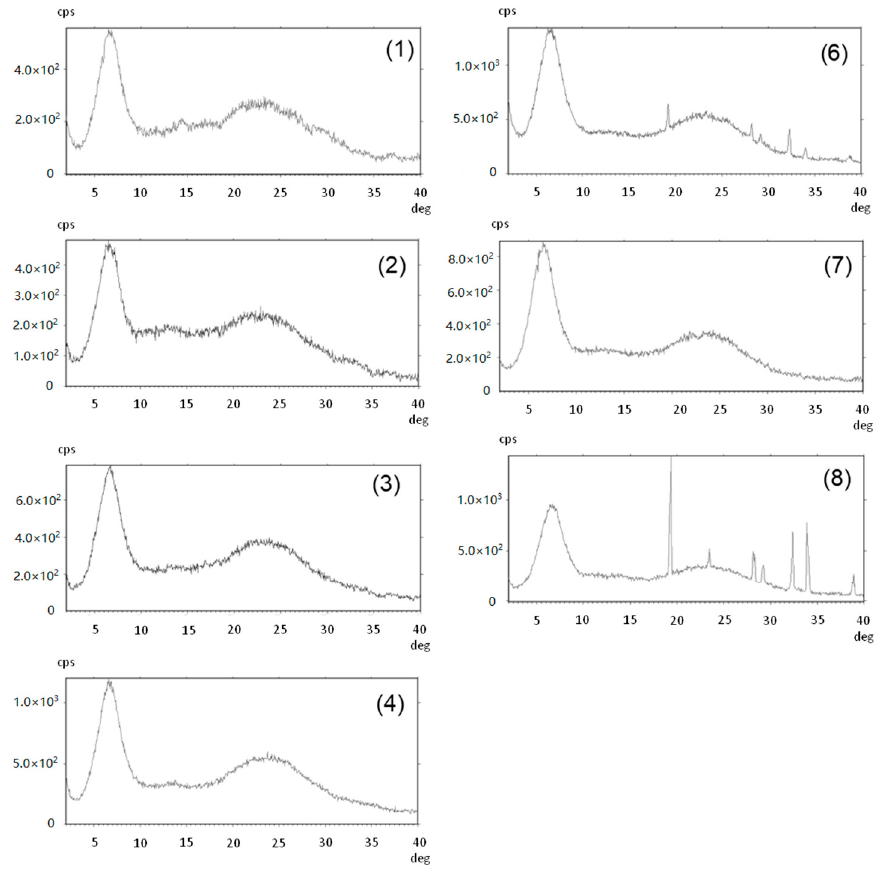
Figure 12. Wide-angle X-ray diffraction (WAXD) measurements performed in powder samples of poly-4’,6-PO- BF3k belonging to seven different batches of the polymer. The number between parentheses denotes the batch of the polymer as shown below in the Table 1.